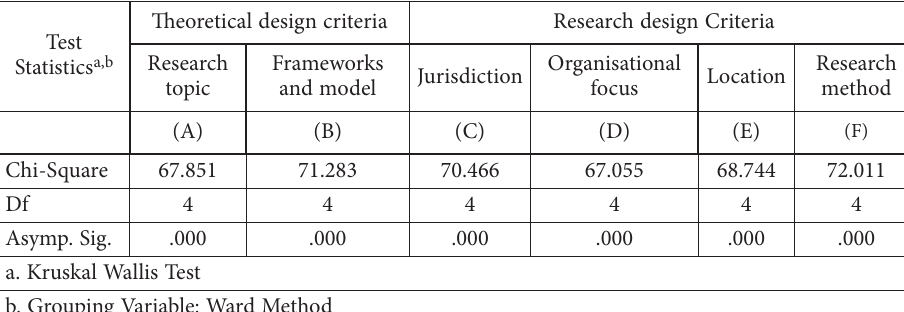
Table 8. Significance test results for clusters’